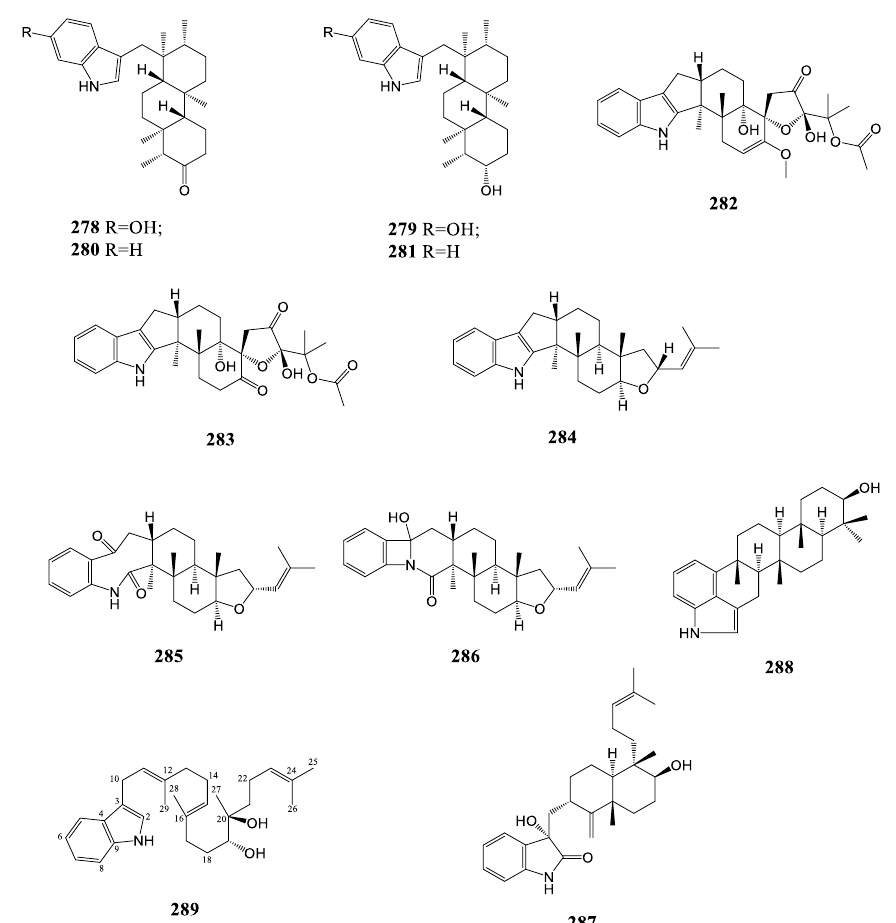
Figure 16. Other non-paxilline-type indole diterpenes.